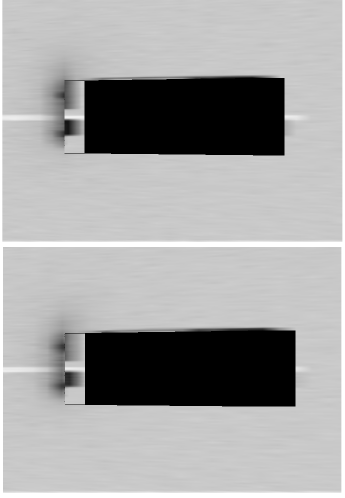
Figure 10. New pair of the orthophotos generated using the updated 3D model of the runway. The black areas represent the regions of the runway that are invisible from the camera’s point of view (i.e. occluded by the foreign object). Note that the pixels representing the roof of the firetruck are now located on the place where the firetruck is positioned. !